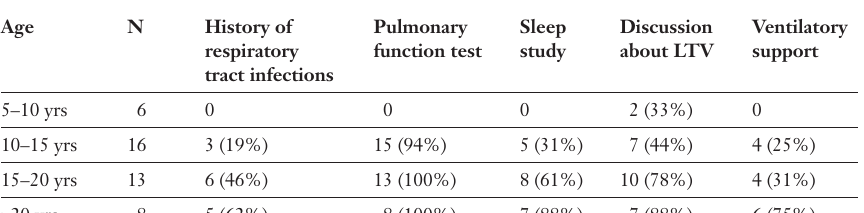
Results from the DMD patient survey on respiratory